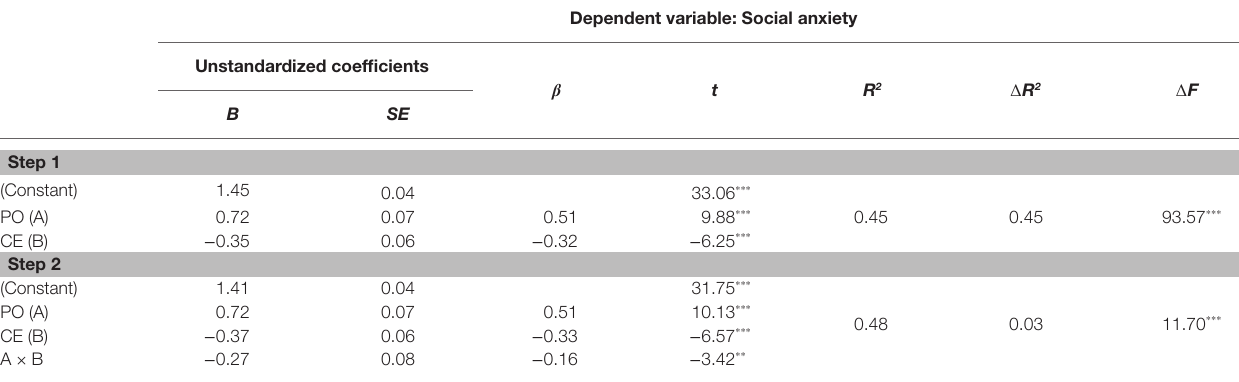
TABLE 4 | Moderating effect of collective efficacy on social anxiety.